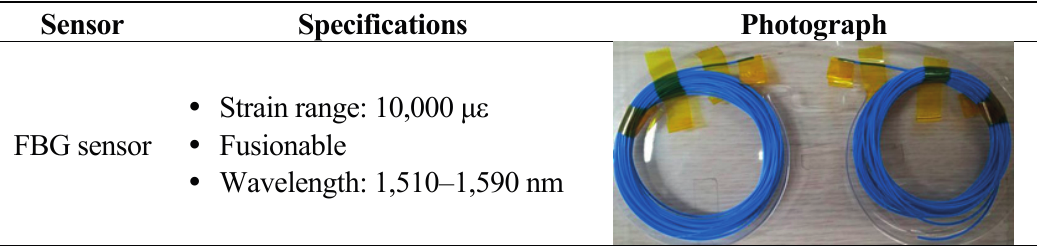
Table 1. Specifications of optical fiber sensor.